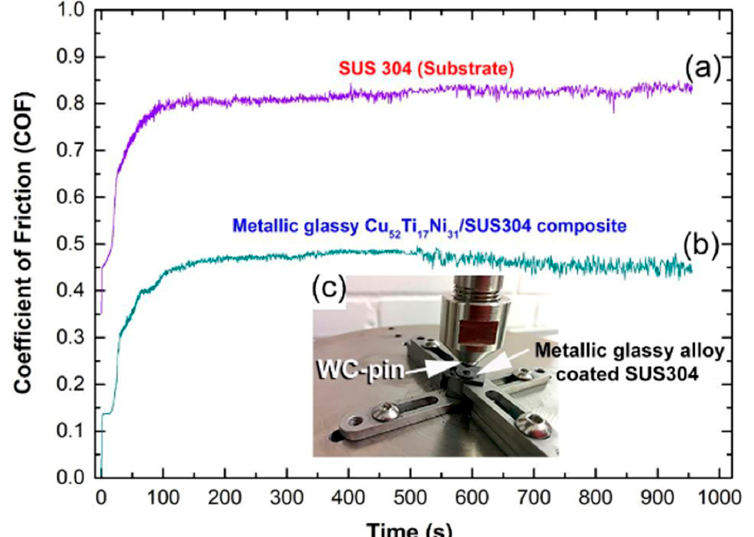
Figure 7. Comparison of the coefficient of friction of CuTiNi BMG cold spray coating with 304 steel substrate where ( a ) is the untreated 304 substrate, ( b ) the 304 substrate with Cu-based metallic glass coatings and ( c ) the experimental set-up for the wear testing [163].